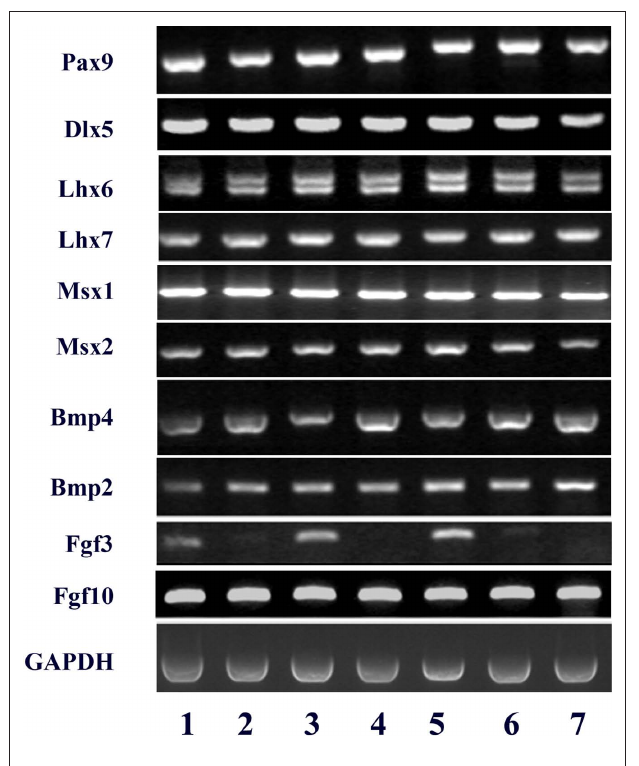
FiGuRe 5 | RT-PCR analysis of the expression of a series of gene transcripts (Lhx6, Lhx-7, Pax9, Dlx5, Msx1, Msx2, Bmp2, Bmp4, Fgf3, and Fgf10) in dissociated dental mesenchymal cells from eD14, eD16, and eD18 mouse embryonic first lower molars (respectively lanes 1, 3, and 5), and from the same cells cultured for 4 days (14 + 4: lane 2, 16 + 4: lane 4, and 18 + 4: lane 6) and in the pulpal clone A4 (lane 7). GAPDH was used as an internal control.